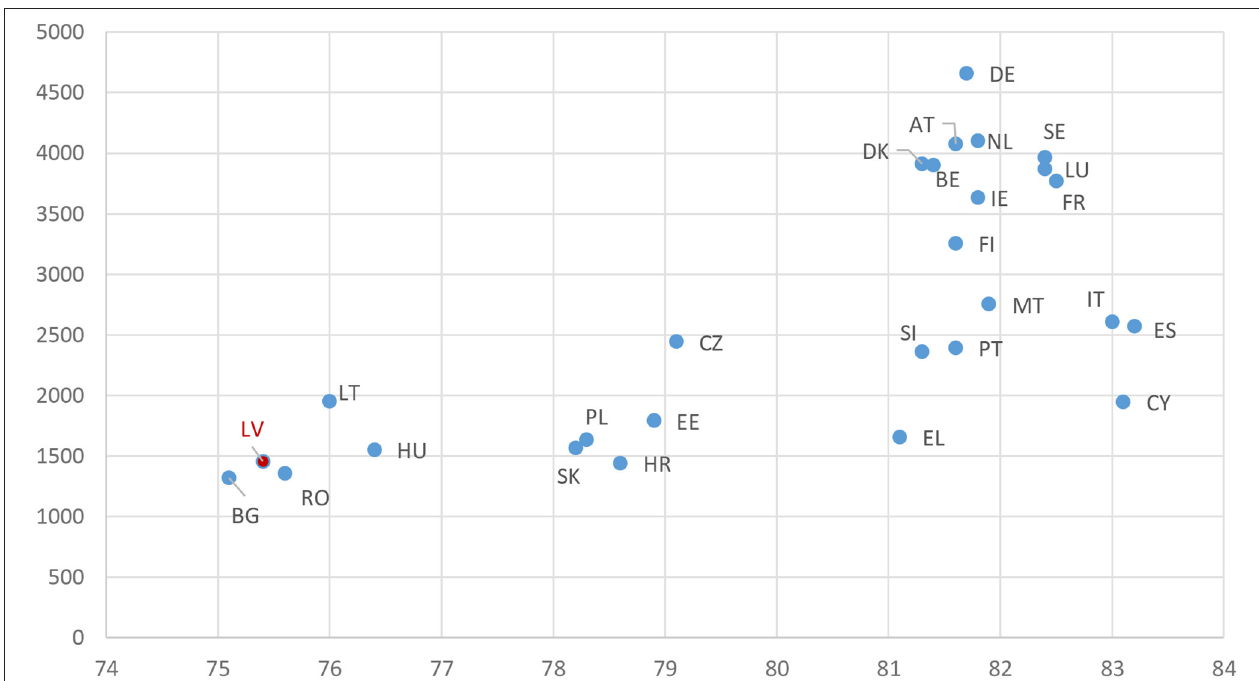
FIGURE 12 | Life expectancy at birth (years) and healthcare expense per inhabitant adjusted with purchasing power (euros) in EU countries in 2019 (33, 36, 37). Source: Eurostat (online data codes hlth_sha11_hf and demo_gind) and WHO